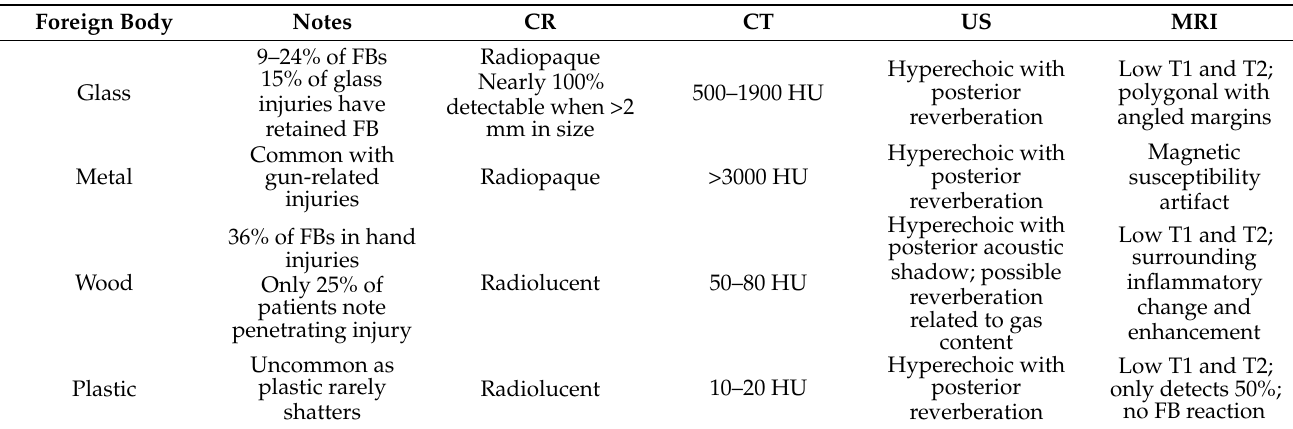
Figure 4. A 30-year-old man with right hand pain after climbing a telephone pole. Axial ( a ) and sagittal ( b ) CT images demonstrate a 1.4 cm linear density compatible with a wood splinter (arrows), extending from the palmar subcutaneous tissues to the flexor retinaculum. Table 3. Summary of foreign body imaging